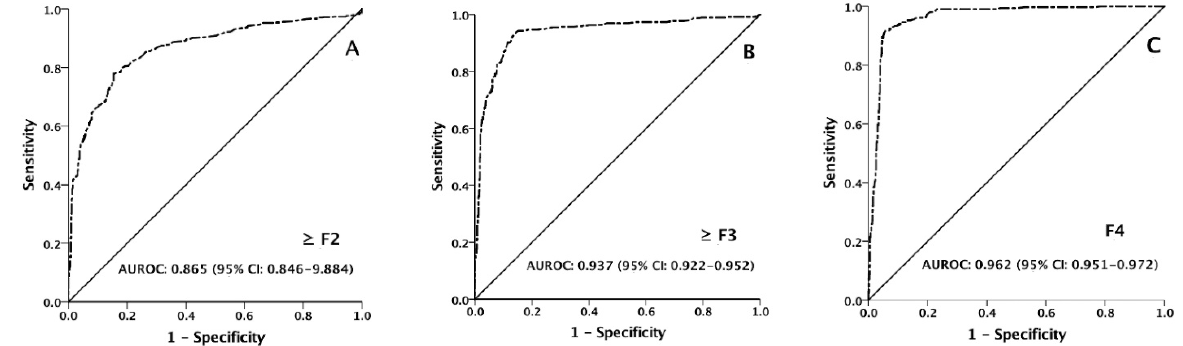
Figure 4. ROC curves of M2BPGi in predicting patients with fibrosis stages of ≥ F2, ≥ F3, and F4. The AUROCs were 0.865 (95% CI: 0.846–0.884) for ≥ F2 ( A ), 0.937 (95% CI: 0.922–0.952) for ≥ F3 ( B ), and 0.962 (95% CI: 0.951–0.972) for F4 ( C ), respectively. 3.4. Selective M2BPGi Cutoff Values to Predict the Severity of Hepatic Fibrosis The maximal Youden indices of M2BPGi in predicting patients with fibrosis stages of ≥ F2, ≥ F3, and F4 were 1.72, 2.65, and 3.93, with sensitivities of 81.3%, 88.1%, and 98.1%; specificities of 80.6%, 85.1%, and 95.0%; PPVs of 87.1%, 75.0%, and 84.3%; NPVs of 72.9%, 93.4%, and 99.5%; and accuracies of 81.1%, 86.2%, and 95.7%, respectively (Table 3). For diagnosing ≥ F2, the M2BPGi cutoff index of 1.51 had a negative LR of 0.10, sensitivity of 92.4%, and a NPV of 95.9%; the cutoff index of 2.08 had a positive LR of 10.0, specificity of 93.5%, and a PPV of 94.2%. For diagnosing ≥ F3, the M2BPGi cutoff index of 2.48 had a negative LR of 0.10, sensitivity of 92.2%, and a NPV of 95.1%; the cutoff index of 2.87 had